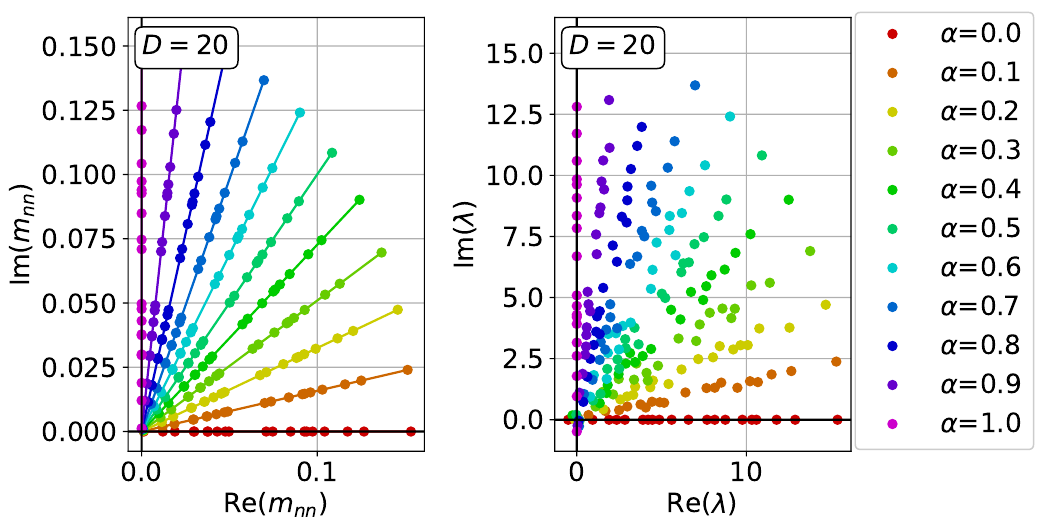
Figure 4: Representative diagonal elements (left) and eigenvalues (right) of the sorted truncated random matrices, see Sec.